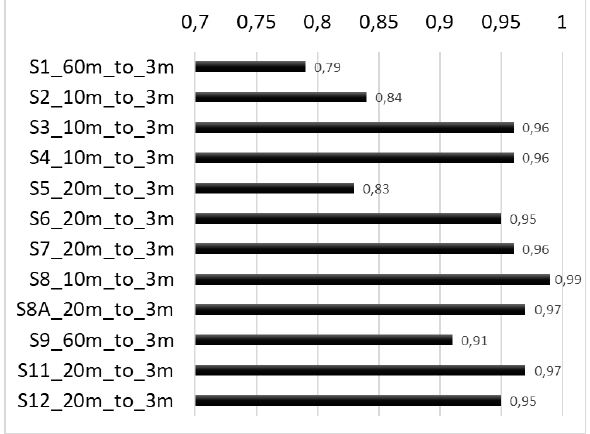
Figure 4 . R 2 performance of the Neural Network straightforward downscaling based on the test dataset.